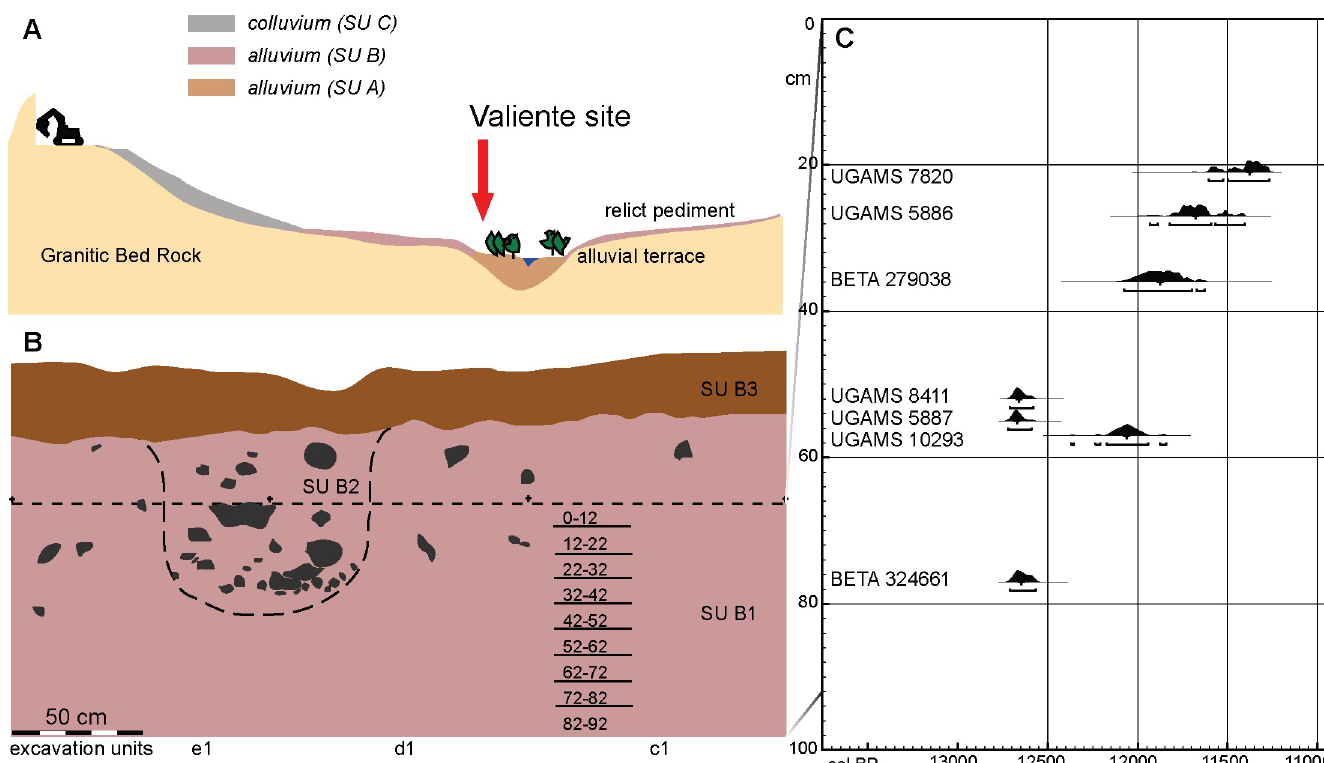
Fig 4. Stratigraphy of Valiente site. A. schematic site profile showing stratigraphic units, B. southwest stratigraphy of excavated units E1, D1 and C1 from area X showing stratigraphic sub units and excavated levels, C. depth/age model of the archaeological deposit.